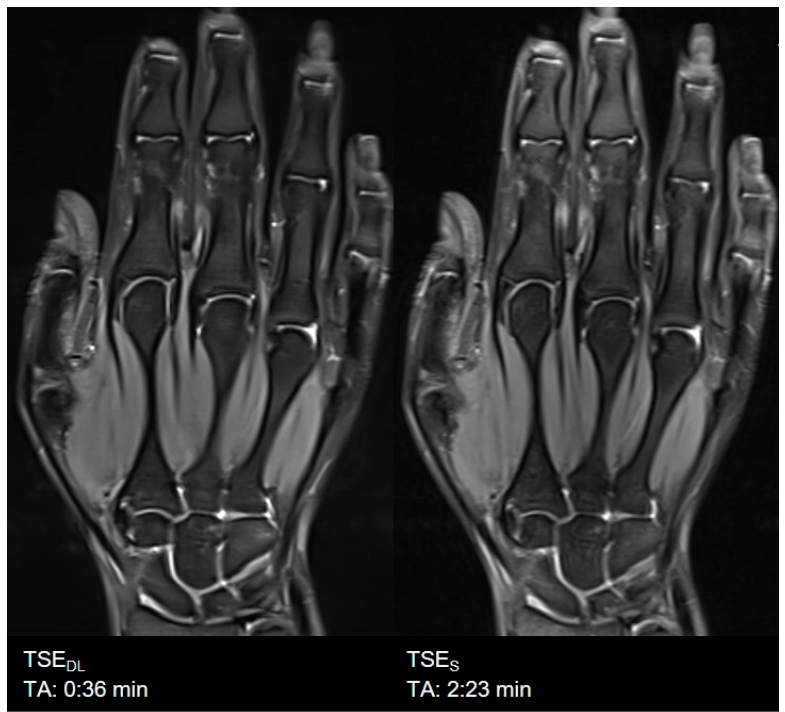
Figure 8. Example of a Deep Learning ( left ) and standard ( right ) PD-weighted turbo spin echo image of the hand in coronal orientation.